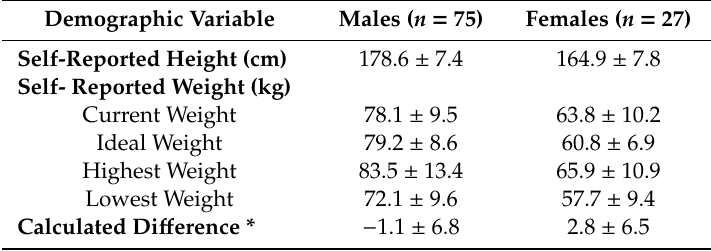
Self-reported physical measurements by demographic variable reported in mean ± standard